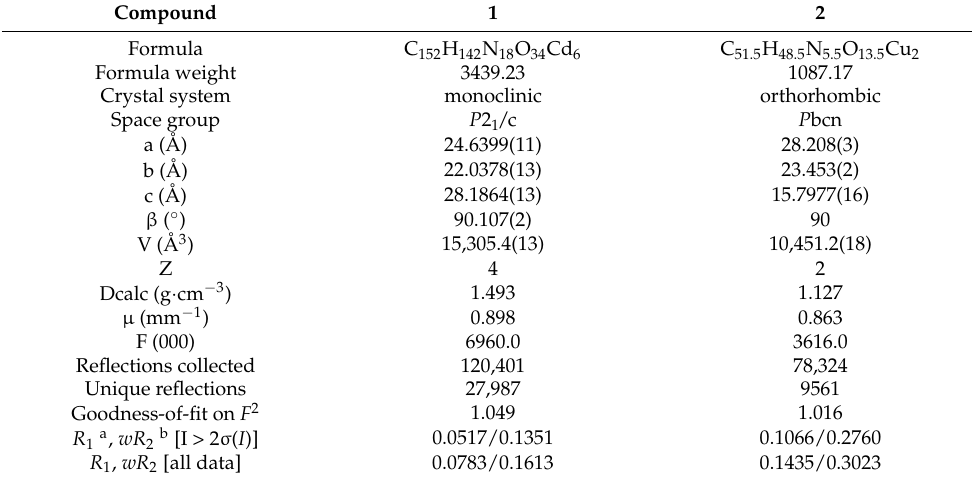
Table 1. Crystal data and refinement results for 1 and 2